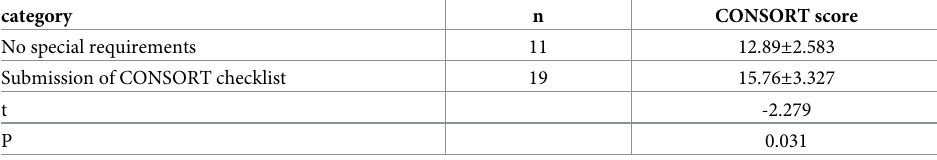
Table 5. The impact of different journal submission requirements on report